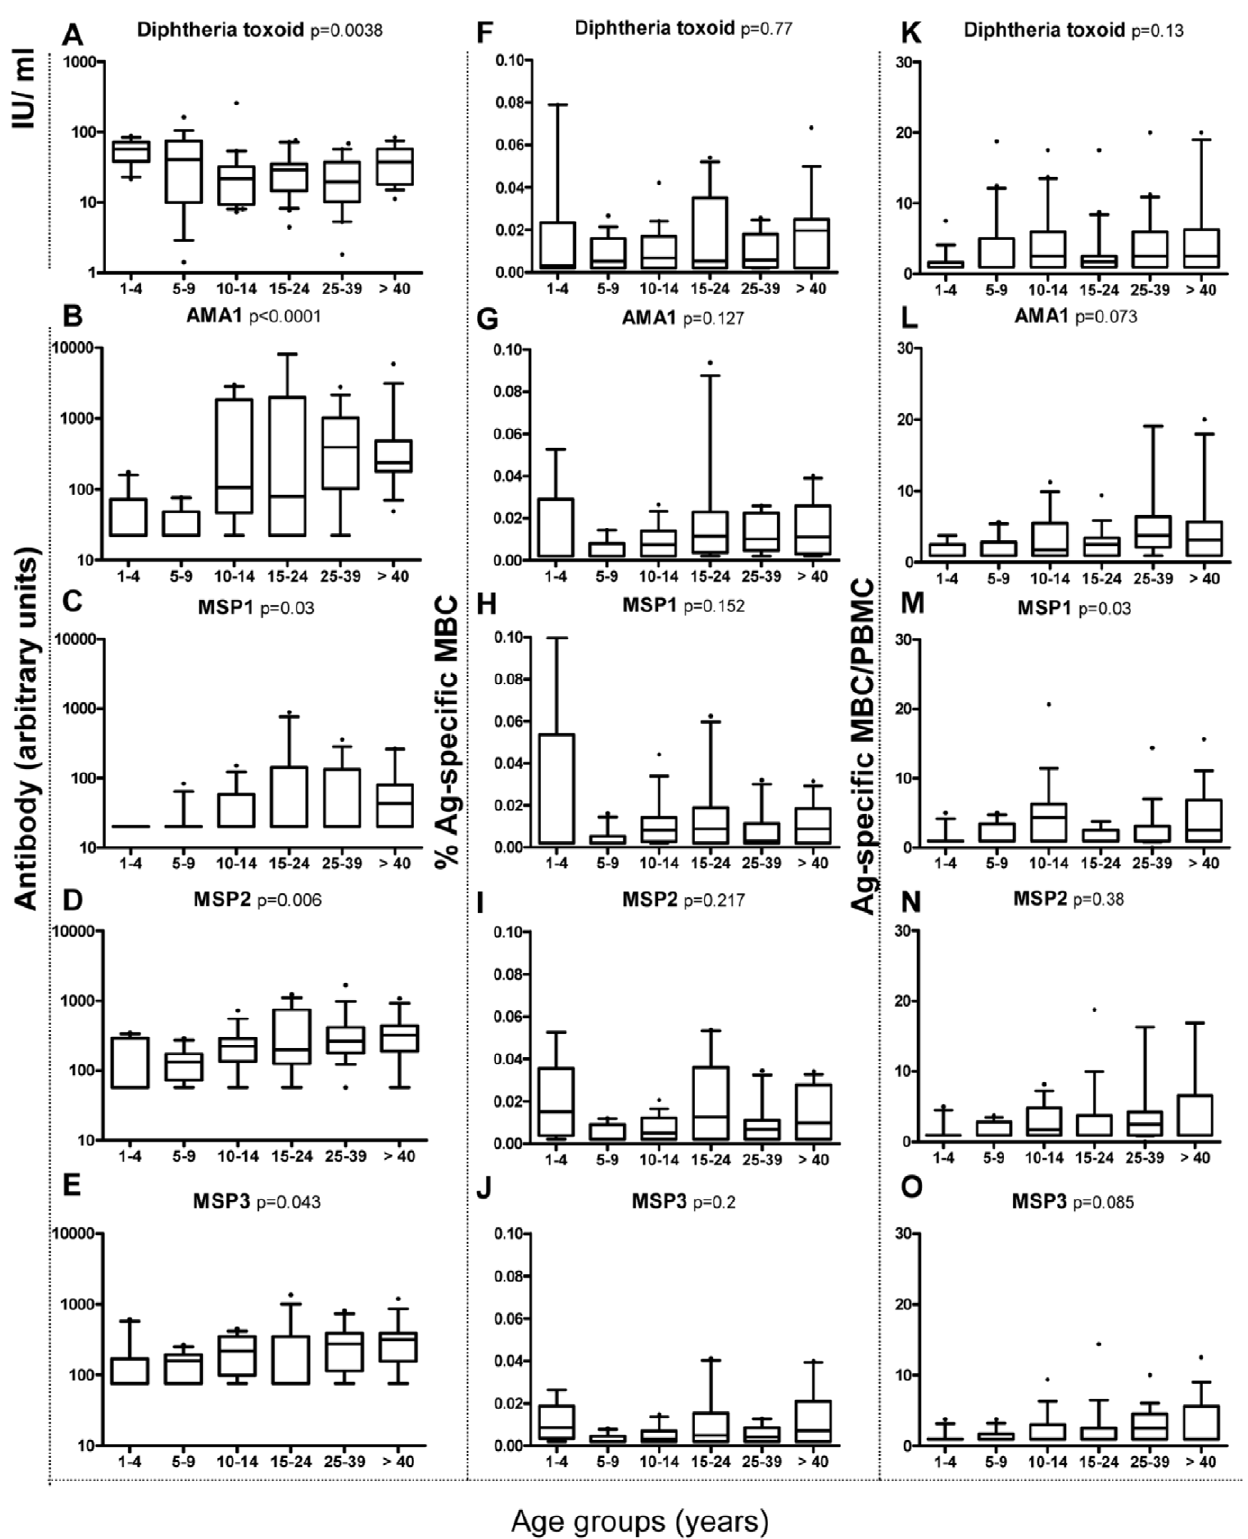
Figure 6. The magnitude of the malaria antigen-specific MBC response does not increase with age. The magnitude of Ag-specific serum IgG (A–E) and of Ag-specific MBC responses [expressed as %MBC (F–J) or expressed as MBC/PBMC (K–O)] are shown for individuals who showed evidence of previous malaria exposure (as defined in Figure 5). Box plots indicate the 25 th , 50 st and 75 th percentile, with whiskers representing the 10th and 90th percentiles. Outliers are denoted by a spot. P values are given for Kruskal-Wallis tests.